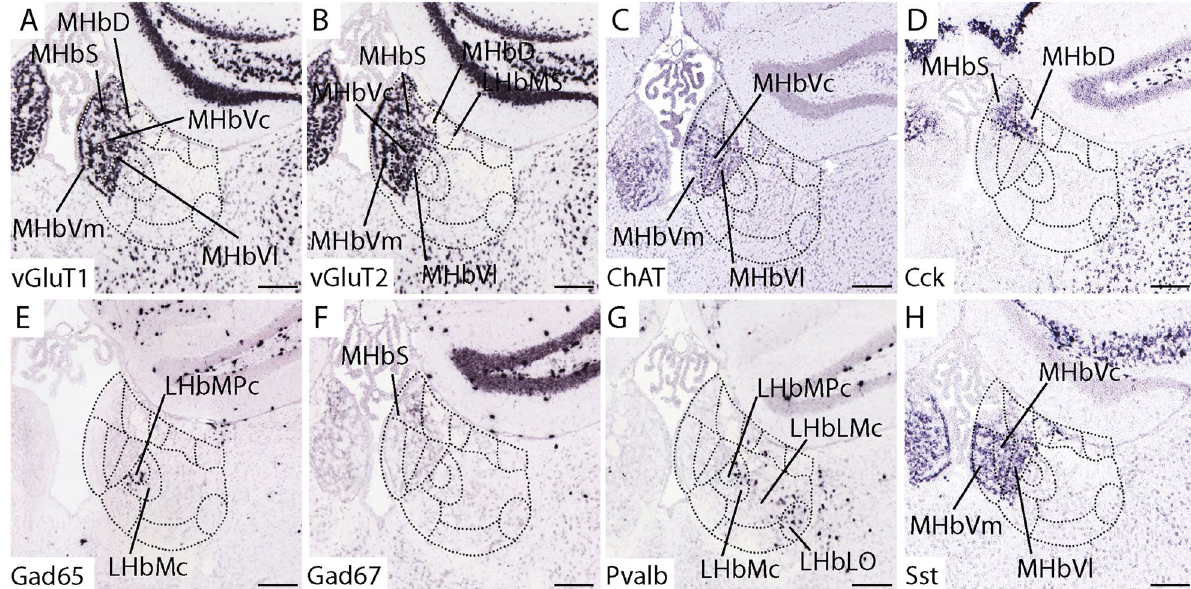
Figure 6. Habenular neuronal cell type distribution. Adult mouse habenula coronal sections displaying the location of specific cell type markers by in situ hybridization. Excitatory neurotransmitters ( A – D ). ( A ) vGlut1 gene, displayed in ventral and dorsal MHb; ( B ) vGlut2 gene, displayed principally in the MHb and in a the LHb as a scattered pattern. ( C ) ChAT gene, displayed in the ventral MHb. ( D ) Cck gene, expressed in the dorsal MHb. Inhibitory neurotransmitters ( E – H ). ( E ) Gad65 gene, displayed in LHb with a specific expression in LHbMPc and LHbMc subnuclei. ( D ) Gad67 gene, displayed in a specific pattern in the MHbS subnulcei. ( E ) Pvalb gene, expressed in specific pattern in the LHbMPc, LHbMc and LHbLO subnulcei, also some scattered positive cells were detected in LHbLMc. ( D ) Sst gene, displayed in the ventral MHb part. Abbreviations: LHb, lateral habenula; LHbLMc: LHbL magnocellular subnucleus; LHbLO: LHbL oval subnucleus; LHbM: LHb medial territory; LHbMC: LHbM central subnucleus; LHbMPc: LHbM parvocellular subnucleus; LHbMS: LHbM superior subnucleus; MHb: medial habenula; MHbD: MHb dorsal subnucleus; MHbS: MHb superior subnucleus; MHbVc: MHb ventral central subnucleus; MHbVl: MHb ventral lateral subnucleus; MHbVm; MHb ventral medial subnucleus. Scale bar: 200 μm. Image credit: Allen Institute for Brain Science. [https:// mouse. brain- map.